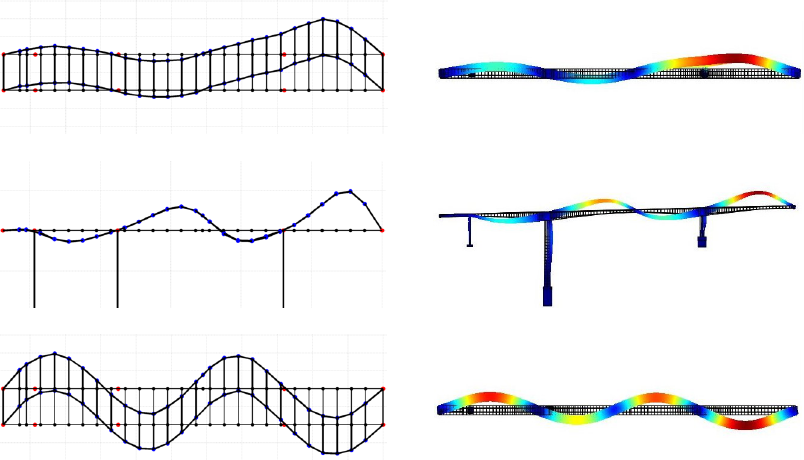
Figure A2. Comparison between the experimentally identified (left column) and nominal FE model predicted (right column) mode shapes of the Metsovo bridge. Modes 4–6.